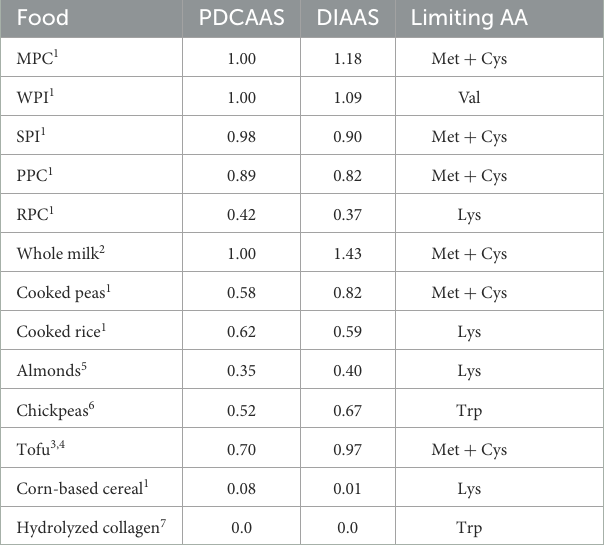
TABLE 1 PDCAAS and DIAAS scores for selected isolated proteins and